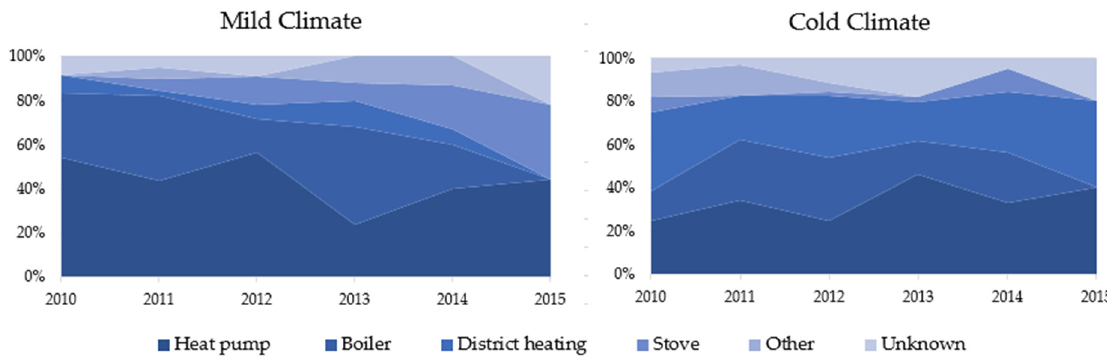
Figure 18. Heating systems technologies trend according to climatic zones. Note: the heating systems technology trend in warm climates has too few nZEBs to be presented.